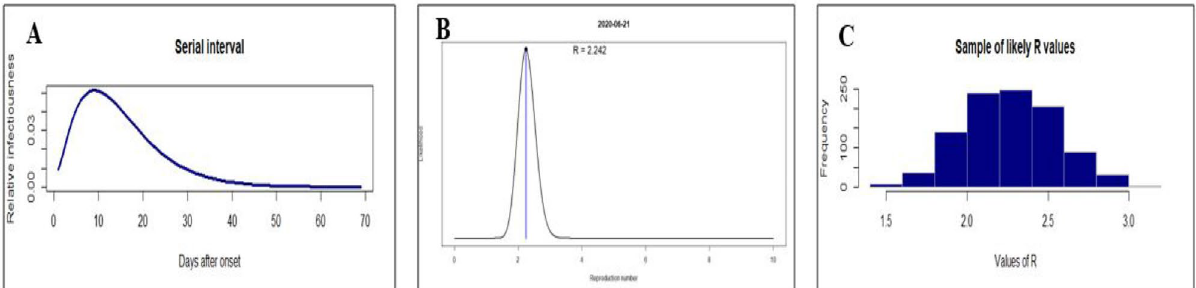
Figure 1. The distribution of serial interval ( A ), the present likely value of reproductive number (R 0 ) estimated by the Maximum-Likelihood (ML) method ( B ), a sample of 500 likely R 0 values using a bootstrap resampling method ( C ) for COVID-19 in Karnataka.